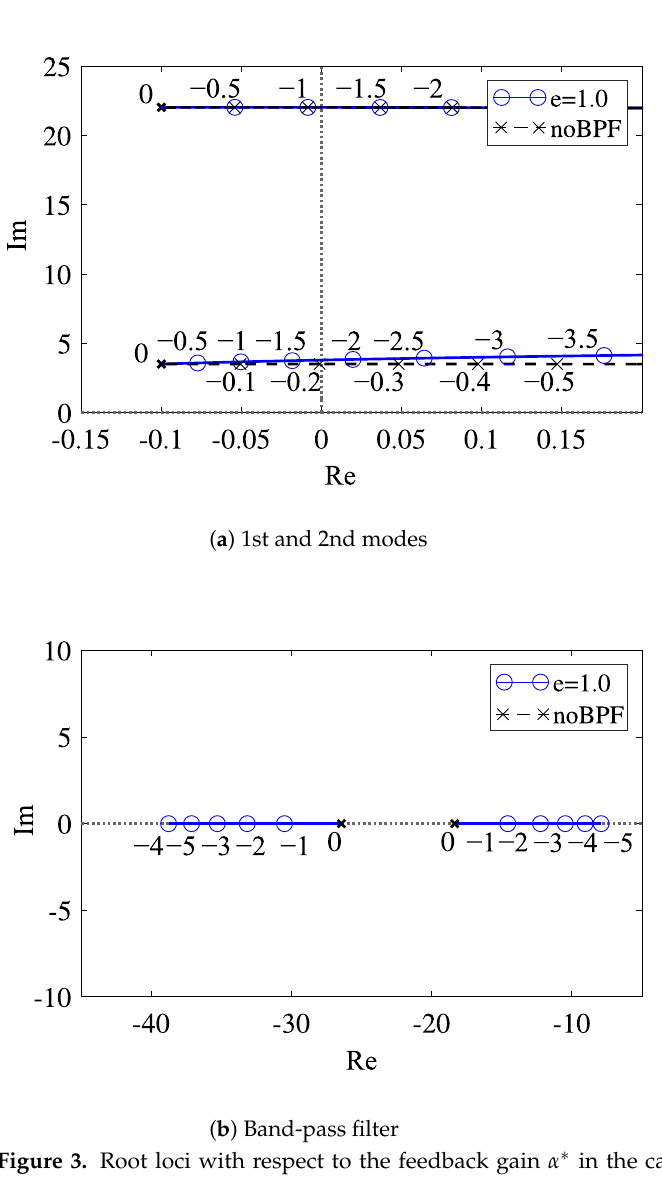
Figure 3. Root loci with respect to the feedback gain α ∗ in the case that the center frequency of the band-pass filter is adjusted to the second mode: ( a ) eigenvalues of the first and second modes; ( b ) eigenvalues of the band-pass